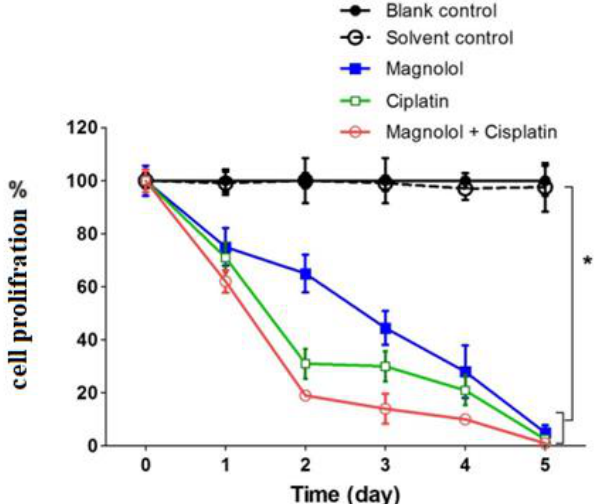
Figure 2. Proliferation assay following treatment of MKN-45 cells with magnolol and/or cisplatin. MKN-45 cells were treated with magnolol and/or cisplatin for 24 h. Then, the proliferation rate was calculated by counting the number of viable cells during five days compared to the control group (*: A significant difference between the cell proliferation % of the control group and other groups.)